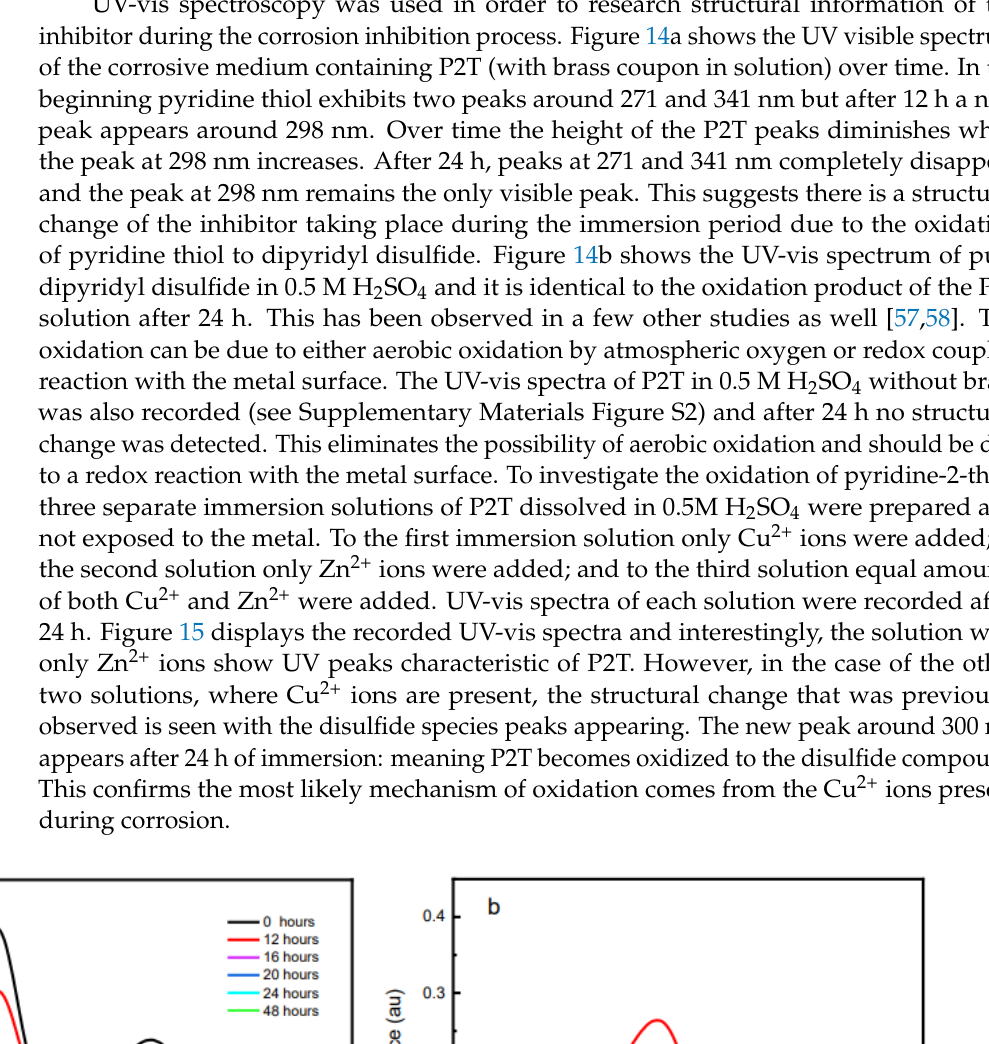
Figure 14. UV-vis spectroscopy of ( a ) P2T inhibited immersion solution over different time intervals and ( b ) UV-Vis